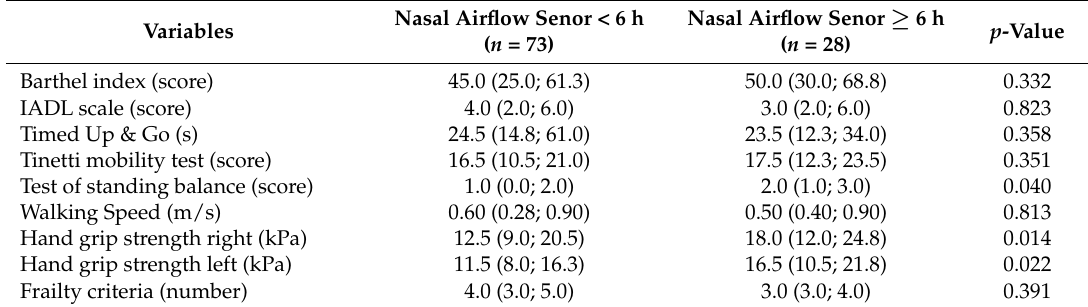
Table 7. Mobility split by tolerance of the nasal airflow sensor ≥ 6 h vs. <6